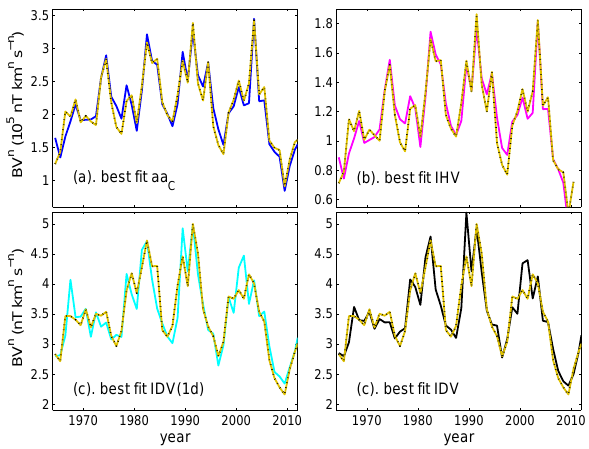
Fig. 3. The variations of four geomagnetic indices over the space age and the best-fit variation of BV n , where B is the near-Earth SW IMF and V SW is the near-Earth solar wind speed. The optimum values of n and the correlation coefficients r are given in Table 1. In each panel, the coloured line is the geomagnetic activity index and the orange and black dashed line is the best-fit variation of BV n . SW (a) The corrected aa index, aa C (blue). (b) The IHV index (mauve).